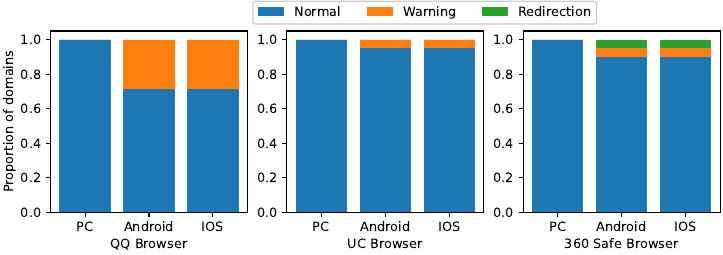
Figure 10. The results of each browser handling the unreported abusive domains.